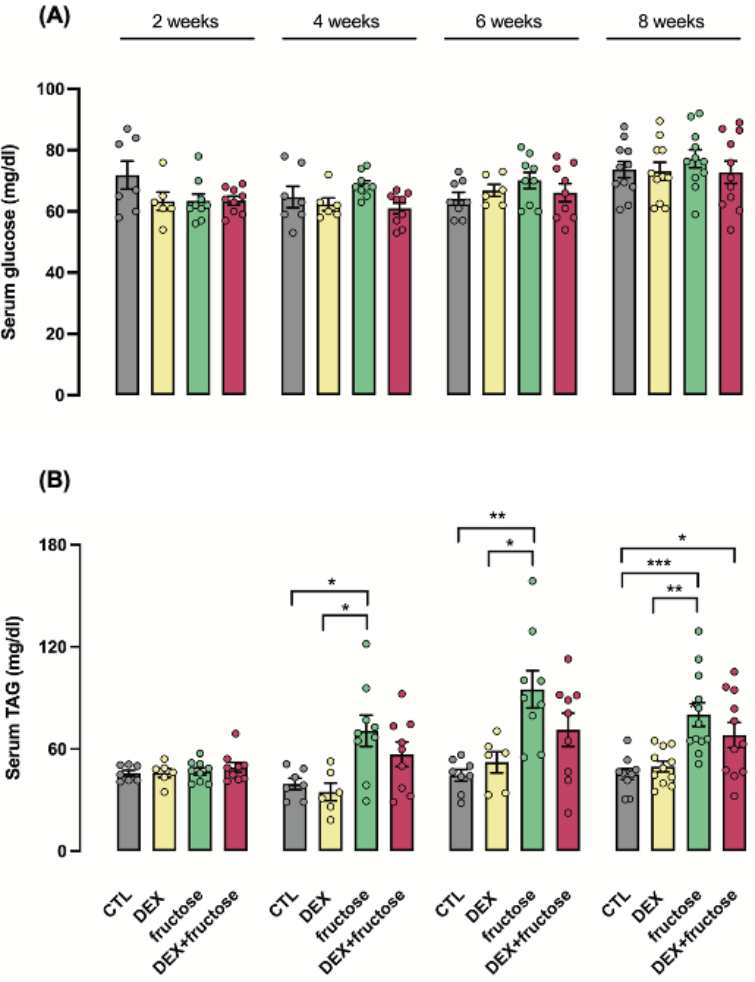
Figure 3. Time course of biochemical parameters (glucose and TAG) in adult rats exposed or not to dexamethasone in utero. At eight weeks of life, male offspring of dexamethasone-treated and untreated dams were divided into two additional groups that were either kept with tap water or 10% fructose ( w / v ) solution ad libitum for the next 8 weeks. The four groups were named as follows: offspring born to untreated mothers that received tap water during adult life (CTL); offspring born to DEX-treated mothers that received tap water during adult life (DEX); offspring born to CTL mothers that received 10% fructose during adult life (fructose); and offspring born to DEX-treated mothers that received 10% fructose during adult life (DEX+fructose). Biochemical parameters were evaluated at 2, 4, 6 and 8 weeks in animals that consumed fructose and age-matched rats consuming tap water. Systemic blood samples were collected to measure glucose ( A ) and triacylglycerol ( B ). Data are presented as the mean ± SEM; * p < 0.05; ** p < 0.01; *** p < 0.001 vs. the group indicated by the bracket. n = 6 to 12 in ( A , B